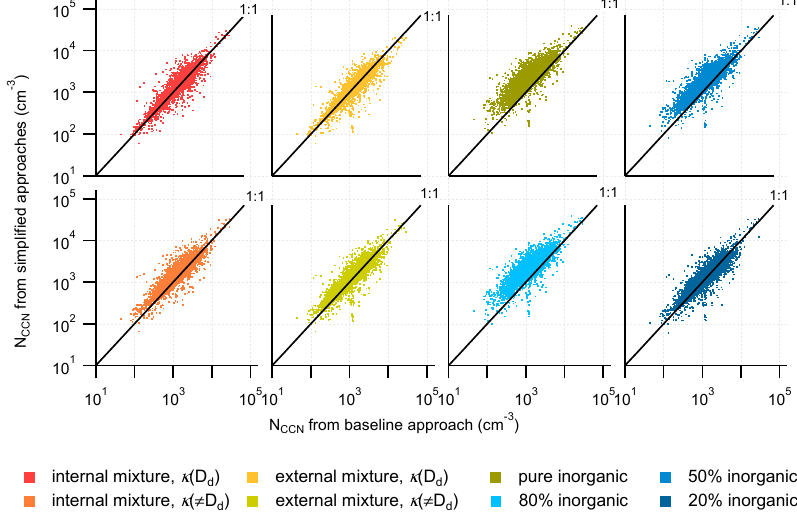
Figure 9. N CCN estimated from simplified approaches vs. that from the baseline approach at 0.85% S for all 2011 data. Table 4. Fit parameters of N CCN estimate approaches for 2011